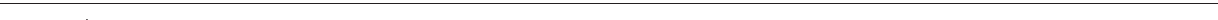
FIGURE 7 | Data are presented as mean ± SEM (unpaired t -test). ** p < 0.01 Bmal1 vs. GFP; * P < 0.05 Bmal1 vs. GFP. (B,C) Relative mRNA and protein expression of Bmal1 and VEGF in HUVECs which had been transfected with Bmal1 siRNA or si-NC. Data are presented as mean ± SEM (unpaired t -test). ** p < 0.01 si-Bmal1 vs. si-NC; * p < 0.05 si-Bmal1 vs. si-NC. (D) Luciferase reporter constructs were created containing the truncated ( − 2,000, − 1,216, − 971, − 785, − 736, − 540, and − 43) versions of the VEGF promoter. The luciferase reporter constructs were co-transfected with Bmal1 overexpression vector or with the control vector into HEK293T cells, and luciferase activity was evaluated 24h later. Data are presented as mean ± SEM (unpaired t -test). ** p < 0.01 and * p < 0.05 Bmal1 vs. PCMV. (E) ChIP assay conducted in HUVECs with anti-BMAL1 or IgG antibody. A qRT-PCR analysis was performed with primer sequences around Bmal1-binding E-box elements in the VEGF promoter. Data are presented as mean ± SEM (unpaired t -test). * p < 0.05 BMAL1 vs. IgG. (F) Relative mRNA expression of Bmal1 and VEGF in HUVECs which had been transfected with/without VEGF siRNA and Bmal1/GFP. Data are presented as mean ± SEM (one-way ANOVA with post-hoc Tukey test). ** p < 0.01 si-NC Bmal1 vs. si-NC GFP; ## p < 0.01 si-VEGF Bmal1 vs. si-VEGF GFP; $$ p < 0.01 si-VEGF GFP vs. si-NC GFP. (G) Endothelial tube formation in matrigel in HUVECs. Data are presented as mean ± SEM (one-way ANOVA with post-hoc Tukey test). ** p < 0.01 si-NC Bmal1 vs. si-NC GFP; # p < 0.05 si-VEGF Bmal1 vs.